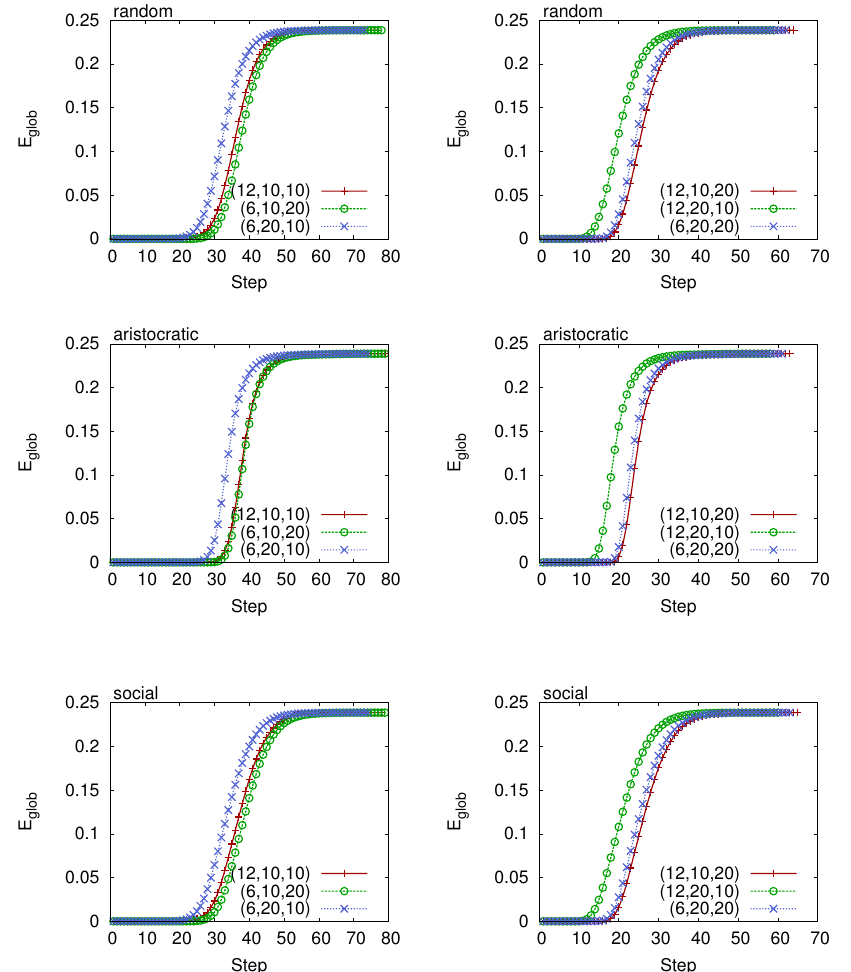
Figure 11. Comparison between the same cost of configurations of the Communities online social network. We consider two cost level C s = 1200 ( left panels ), C s = 2400 ( right panels ), and random, aristocratic, and social rules. All plots refer to the word of mouth model. We clearly see that network efficiency increases faster in configurations that have a higher value of attractiveness, no matter what cost level or rule has been